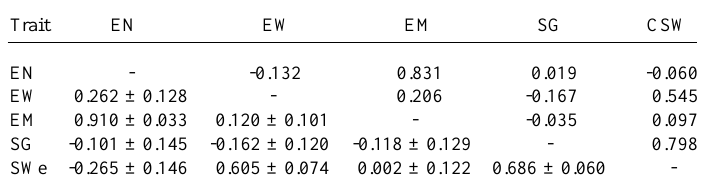
Table III Genetic correlations (below the diagonal) with their standard errors and phenotypic correlations (above the diagonal) between different egg traits.